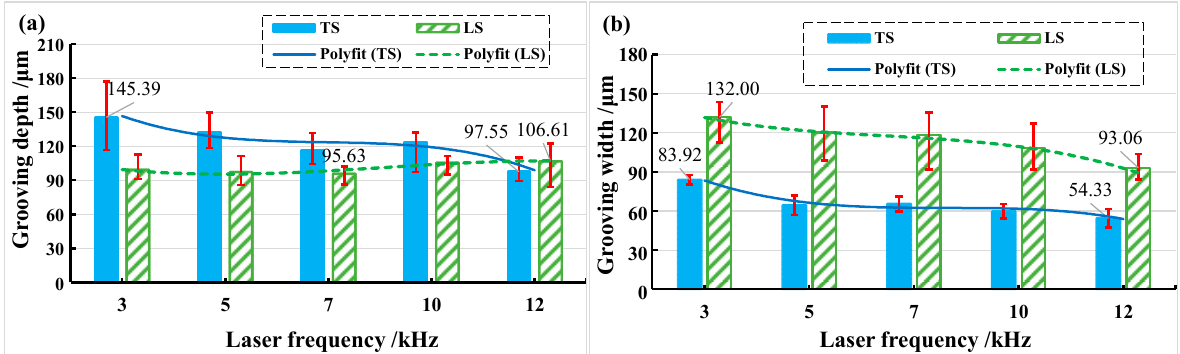
Figure 18. The change in grooving depth and width with increasing frequency in different feeding directions. ( a ) Grooving depth; ( b ) grooving width.